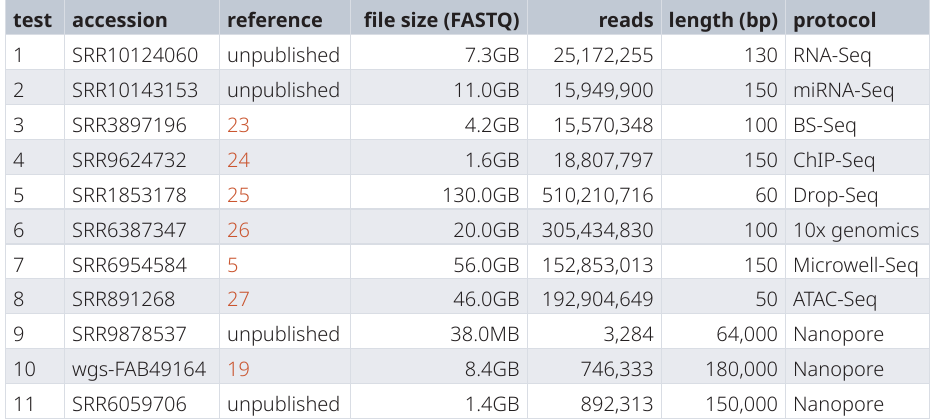
Table 2. Datasets used for comparison with FastQC ’s output and run time speed benchmarking between QC tools. test